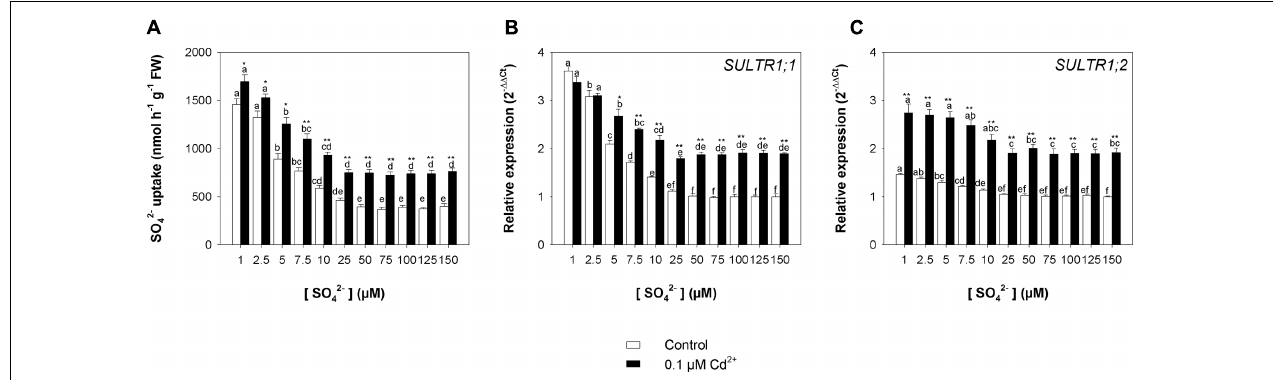
FIGURE 7 | Effect of long-term exposure to Cd on the sulfate uptake capacity of the roots. Arabidopsis plants were grown for 22 days under a wide range of sulfate concentrations (1, 2.5, 5, 7.5, 10, 25, 50, 75, 100, 125, and 150 µ M) in the presence or absence of 0.1 µ M Cd 2 + . (A) Sulfate uptake capacity was evaluated by measuring the rate of 35 SO 42 − absorption into roots of intact plants over a 15-min pulse. The incubation solutions contained 150 µ M SO 42 − . (B,C) Changes in the relative transcript levels of SULTR1; 1 and SULTR1; 2 in the roots. Bars and error bars are means and SE of two experiments run in triplicate ( n = 6). Different letters indicate significant differences ( P < 0.05). Asterisks indicate significant differences (Student’s t -test; ∗ 0.001 ≤ P < 0.05; ∗∗ P < 0.001) between control and Cd-exposed plants grown under the same sulfate external concentration.